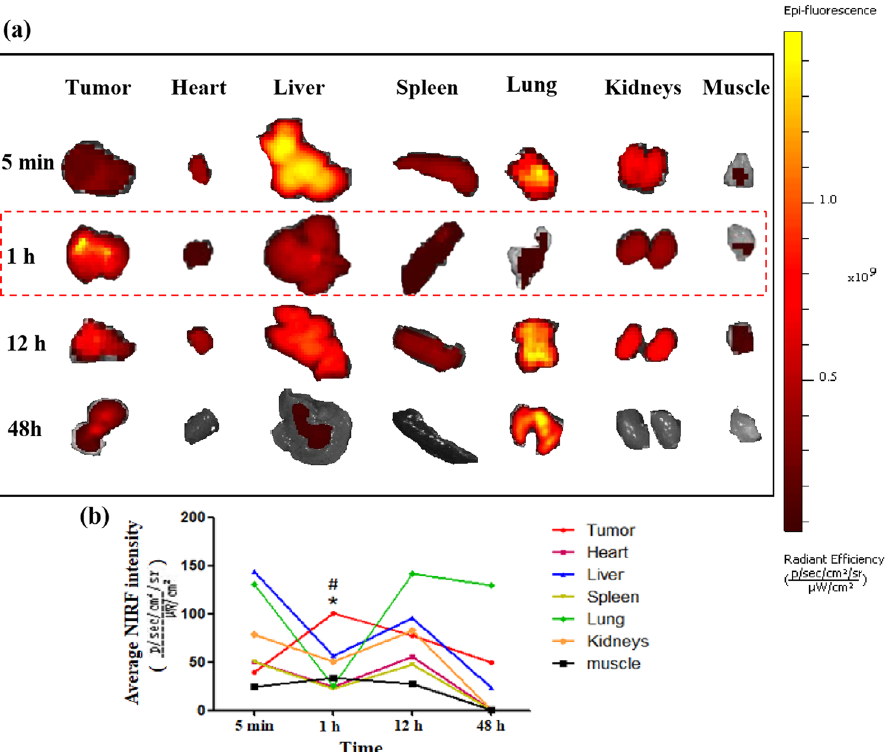
Figure 11. The biodistribution of IR780-NBs-DTX ex vivo via an IVIS Lumina II imaging station. ( a ) NIRF imaging of the tumor, heart, liver, spleen, lung, kidneys and muscle at 5 min, 1 h, 12 h and 48 h. ( b ) Analysis of the average NIRF intensity of the tumor, heart, liver, spleen, lung, kidneys and muscle at different time points. *P < 0.05, significantly different from the average NIRF intensity of tumors at 5 min, 12 h and 48 h. # P < 0.05, significantly different from the average NIRF intensity of the liver, lung and kidneys at 1